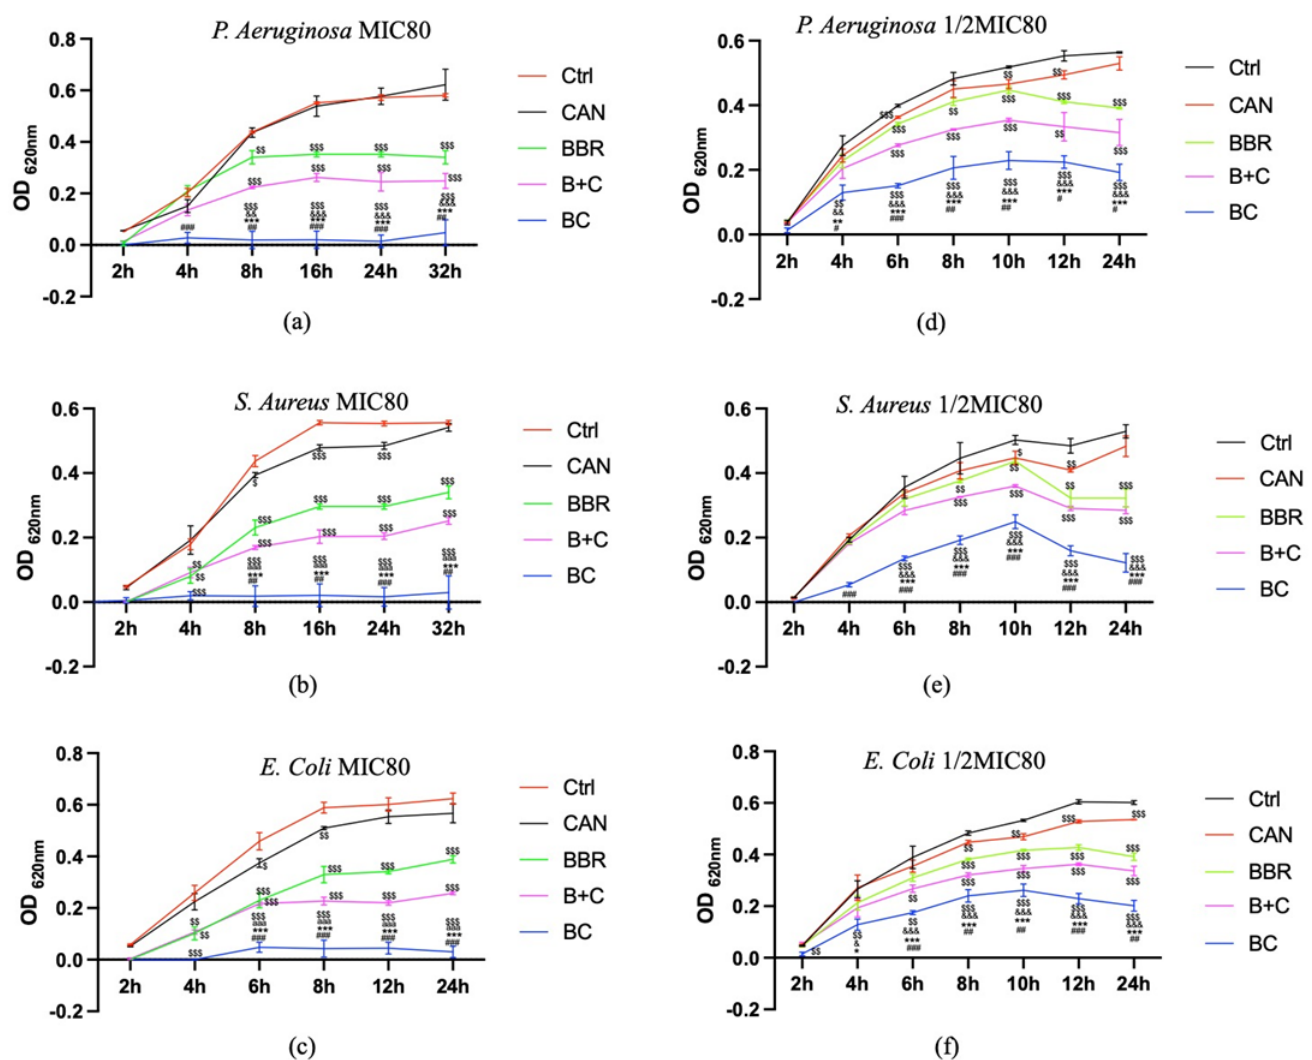
Figure 5. Effects of CAN, BBR, BBR+CAN and BC on E. coli, S. aureus , and P. aeruginosa growth. ( a ) Antibacterial effect of drugs on P. aeruginosa at 0.2 mM; ( b ) Antibacterial effect of drugs on S. aureus at 0.4 mM; ( c ) Antibacterial effect of drugs on E. coli at 0.4 mM. Changes in the inhibitory effects of ( d ) P. aeruginosa ; ( e ) S. aureus ; ( f ) E. coli with time in response to CAN, BBR, B+C and BC at 1/2MIC80. $ p < 0.05, $$ p < 0.01, $$$ p < 0.001 vs. Ctrl; & p < 0.05, && p < 0.01, &&& p < 0.001 vs. CAN; * p < 0.05, ** p < 0.01, *** p < 0.001 vs. BBR. # p < 0.05, ## p < 0.01, ### p < 0.001 vs. B+C. Data were shown as mean ± S.D. (n =